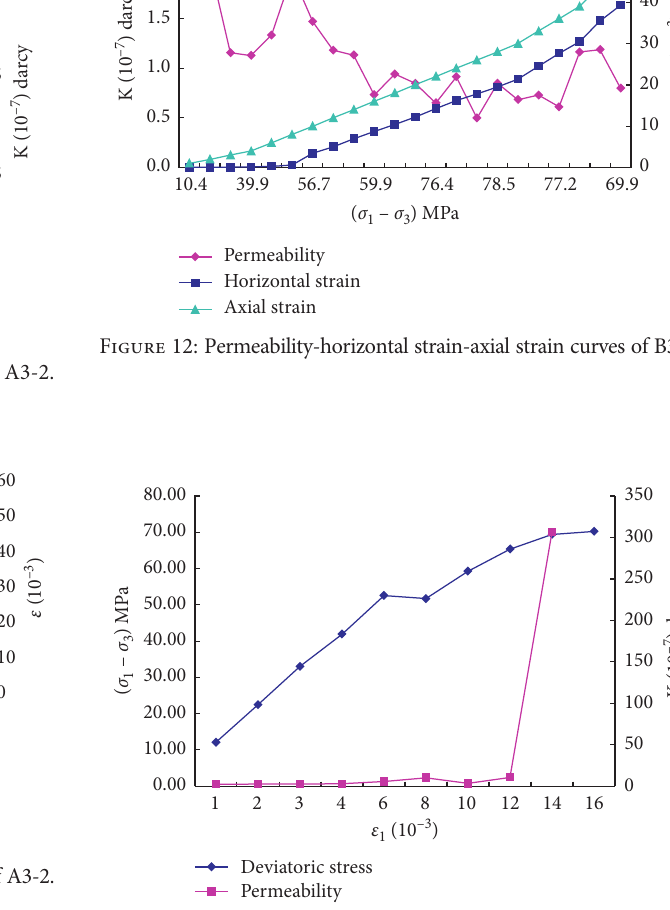
Figure 13: Permeability-principal stress difference curves of